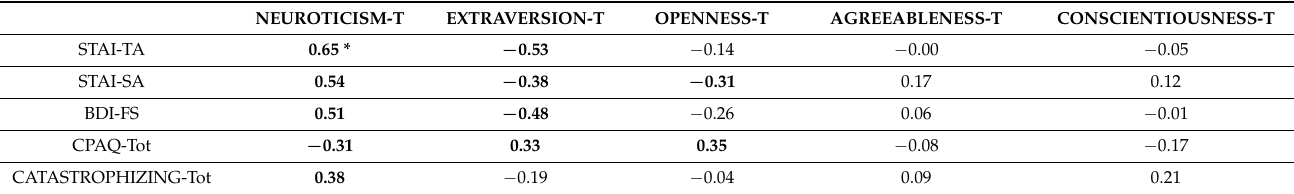
Table 6. Pearson correlations between NEO-FFI and clinical